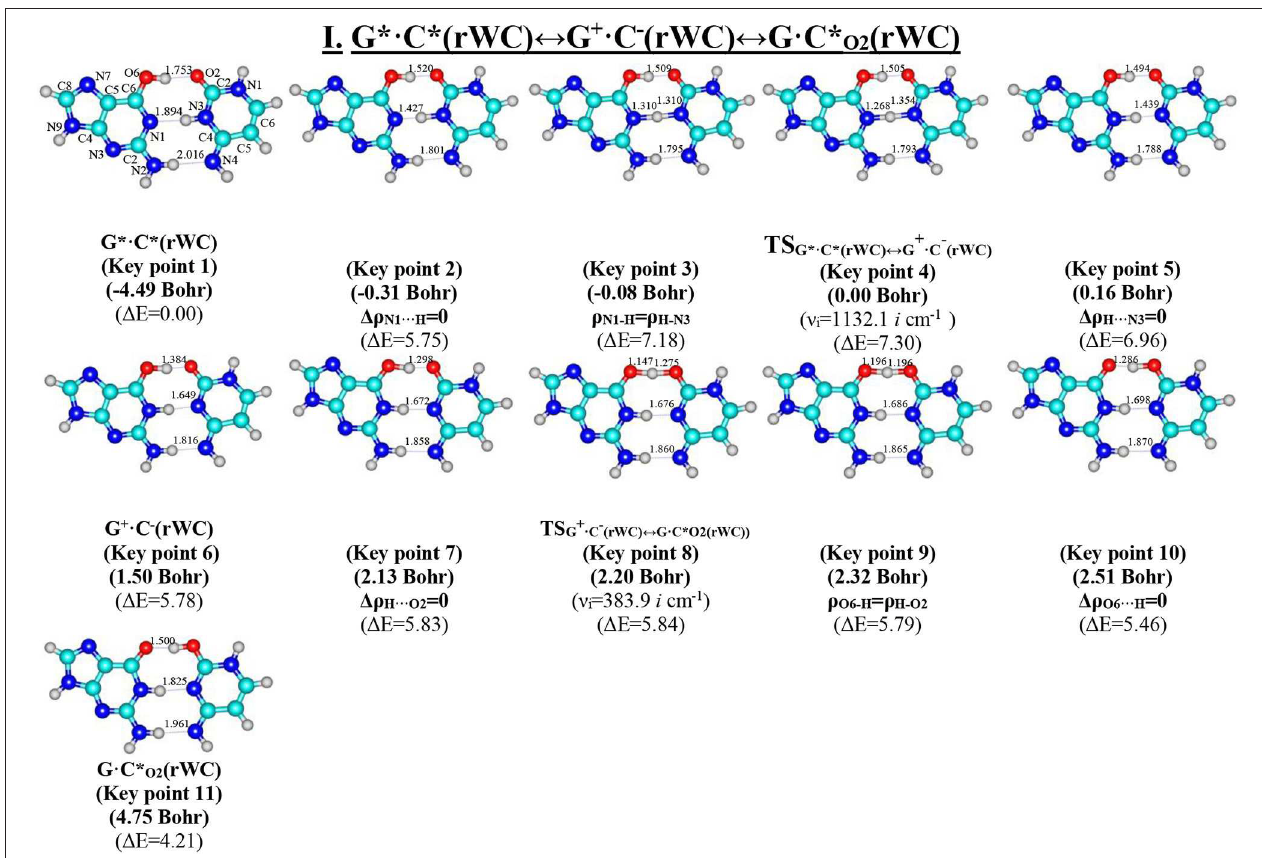
FIGURE 2 | Geometric structures of the 11 key points describing the evolution of the I. G* SPT along the IRC obtained at the B3LYP/6-311 kcal mol − 1 obtained at the B3LYP/6-311 · are presented below them in brackets (see Table 3 ). For more detailed designations see Figure 1